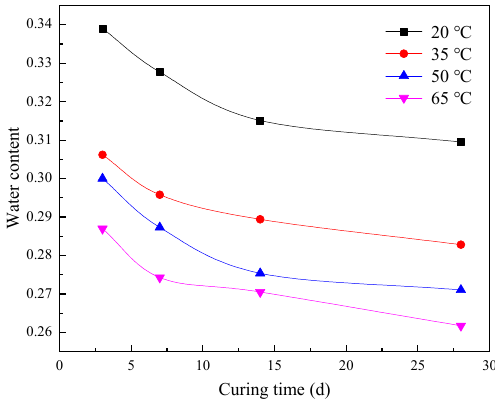
Figure 2. Variation of water content with time at different temperatures.